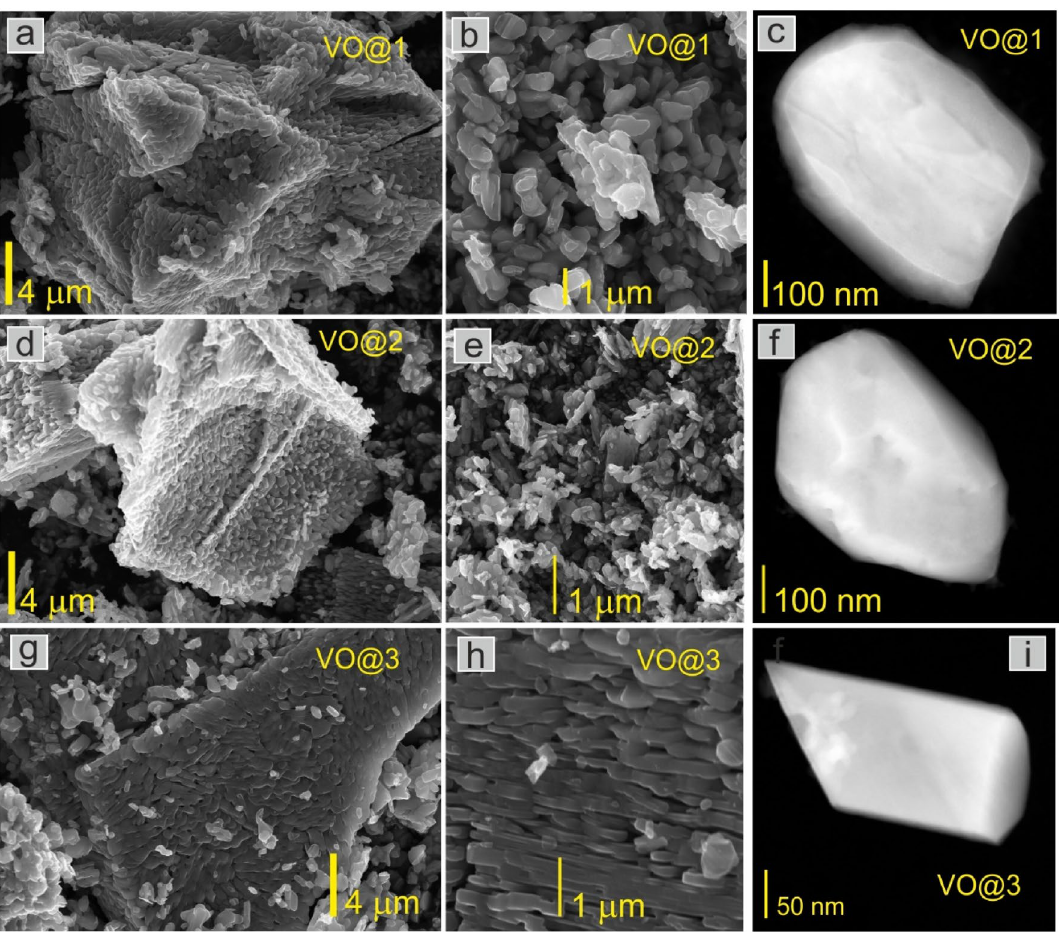
Figure 4. SEM and STEM images of V 2 O 5 powders obtained using a modified sol–gel method using citric acid as the main chelating agent ( a – c ) with acetic acid ( d – f ), ethylene glycol ( g – i ) as the second chelating agent (figure c , f and i are STEM